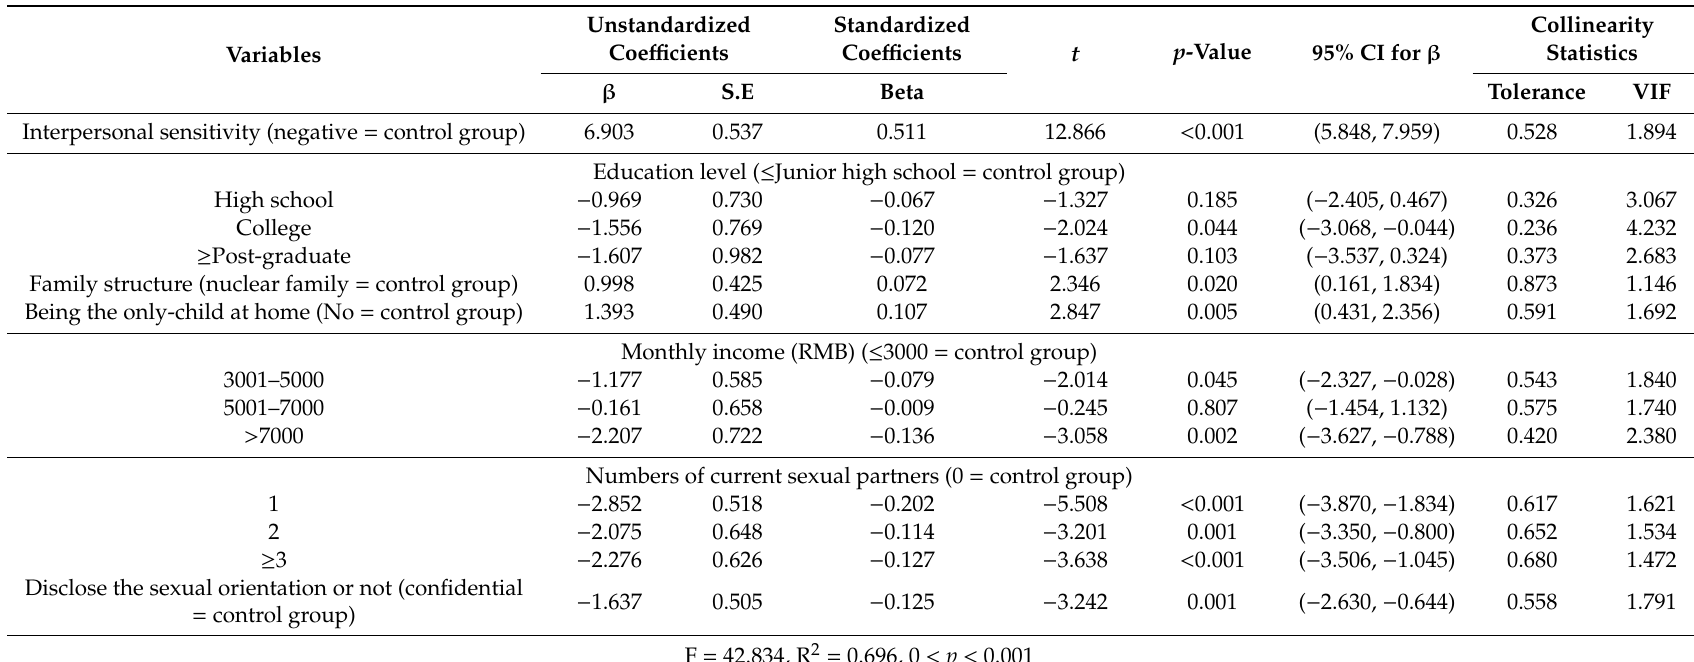
Table 4. Estimated adjusted associations ( β and 95% CI) of loneliness by interpersonal sensitivity and other factorss.